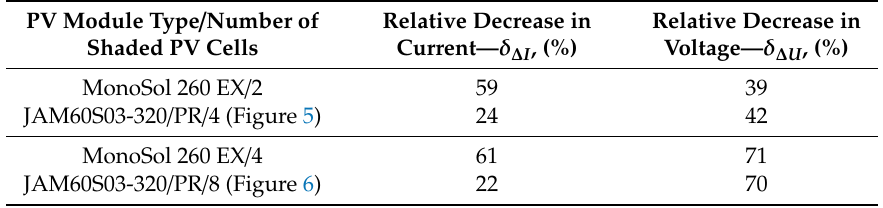
Table 5. Comparison of partial shading effects for two monocrystalline silicon PV modules expressed in relative values (made of 60 whole PV cells, based on results from work [23] and 120 half-cells cells—from Table 1).